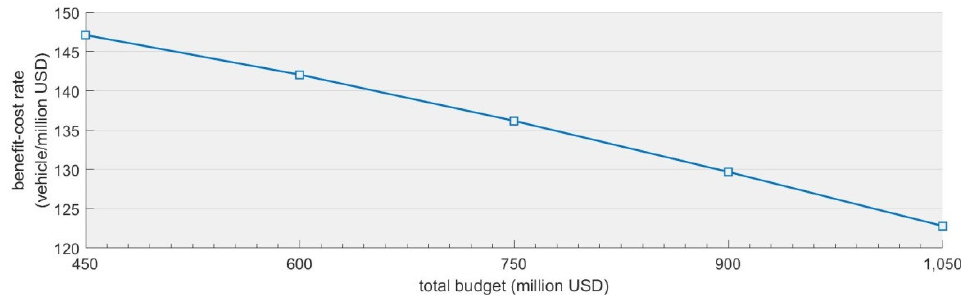
Figure 16. The benefit–cost rates under different budgets.